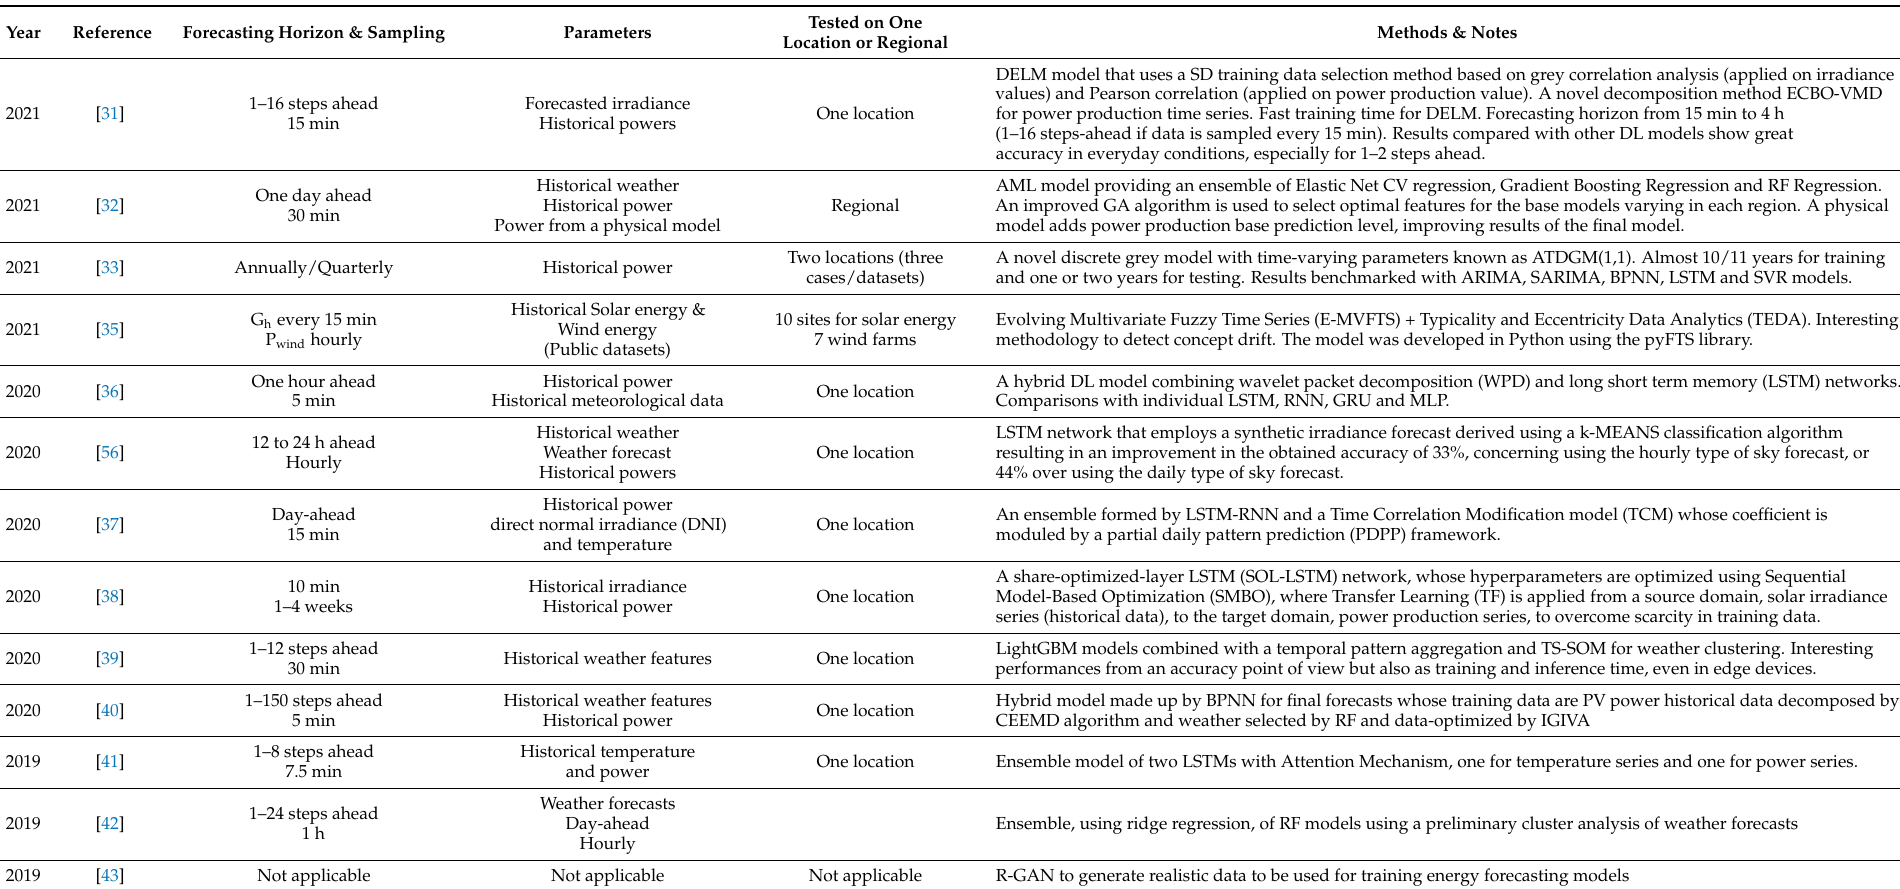
Table 2. Point-forecast ML-based methods for PV power production. Publication year considered: